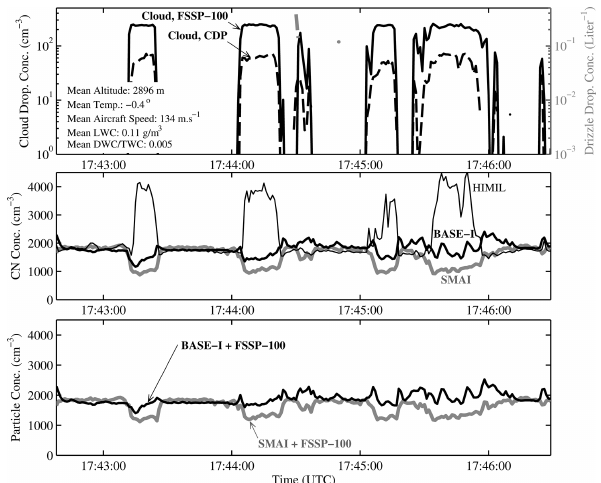
Figure 3. Performance of three aerosol inlets on the C-130 air- craft during a drizzle-free cloud penetration during PLOWSff03 (3 November 2009) flight. LWC: liquid-water content from the King probe; DWC: drizzle-water content from 2D-C probe; TWC (total water content) = DWC + LWC.